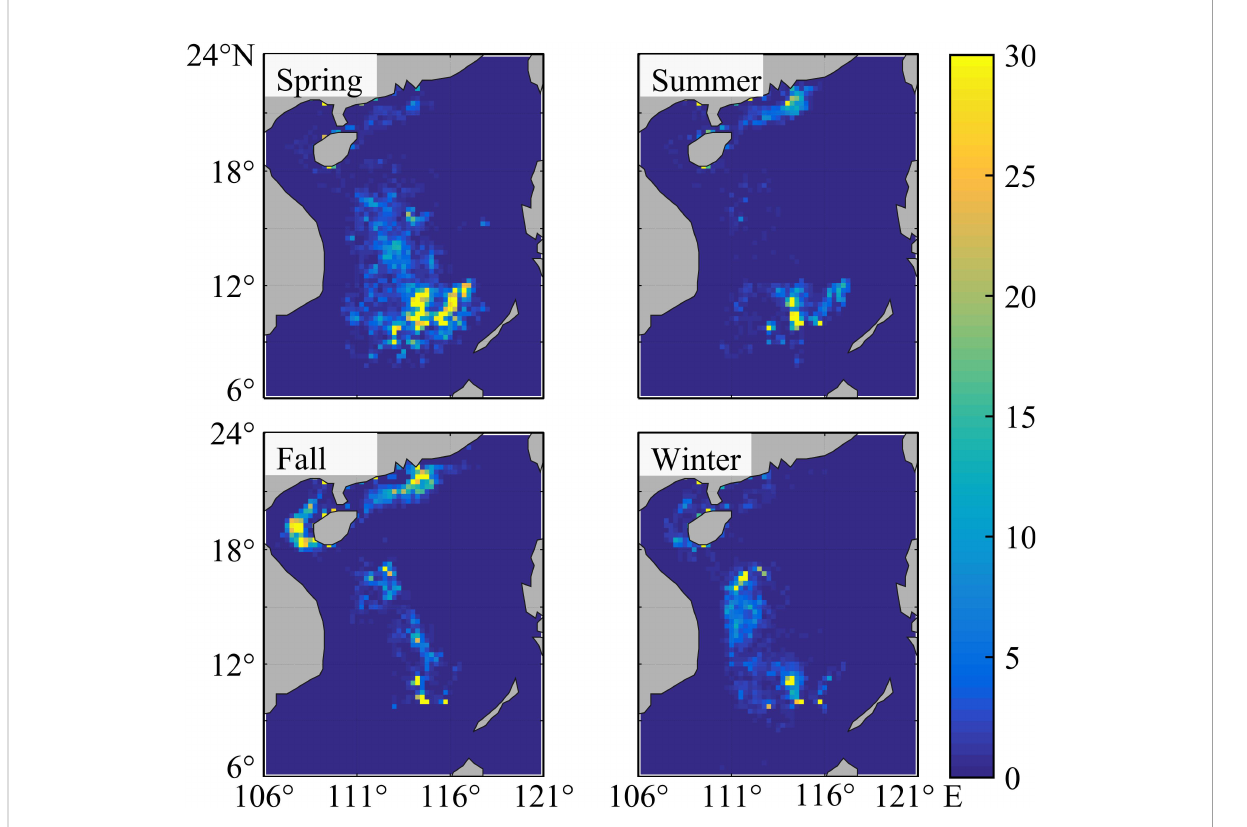
FIGURE 7 Seasonal distribution of large-size light falling-net vessels in the South China Sea.